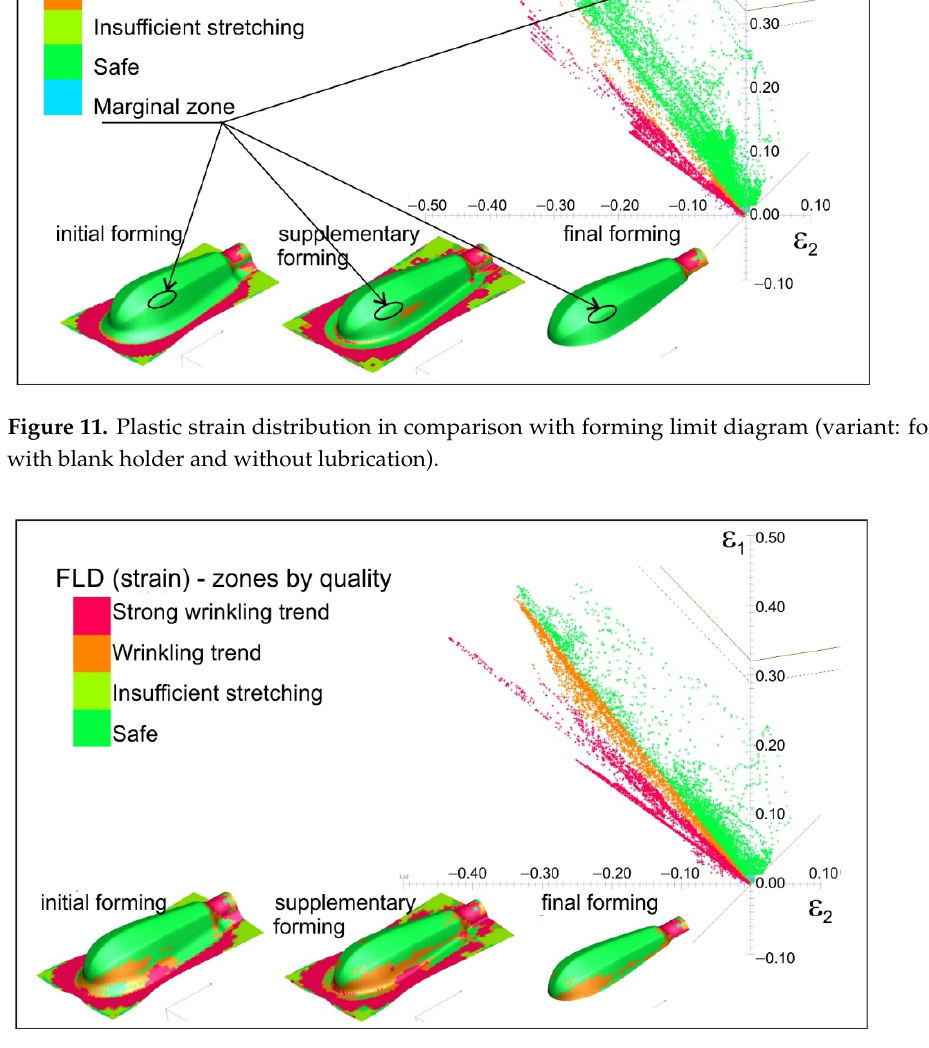
Figure 12. Plastic strain distribution in comparison with forming limit diagram (variant: forming with blank holder and with lubrication).